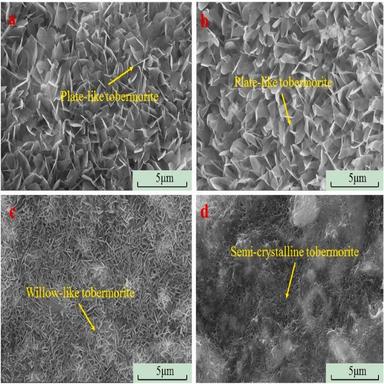
Effects of water-repellent agents on the hydration products of AAC: (a) SP, (b) OC, (c) ZS, (d) WZS.